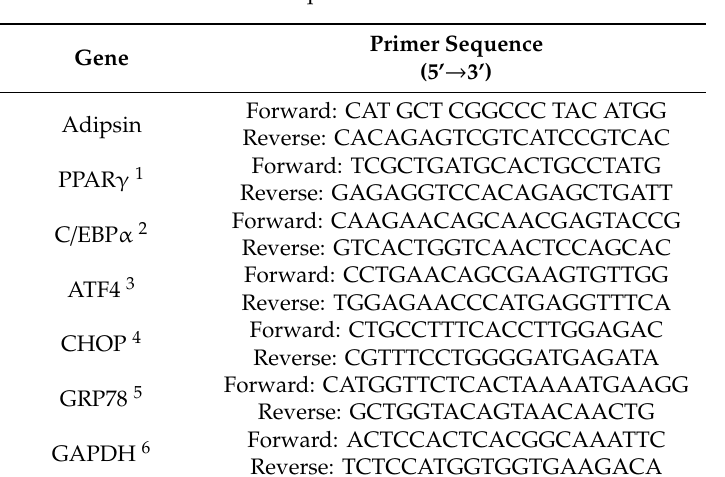
Table 1. Primers for quantitative real-time